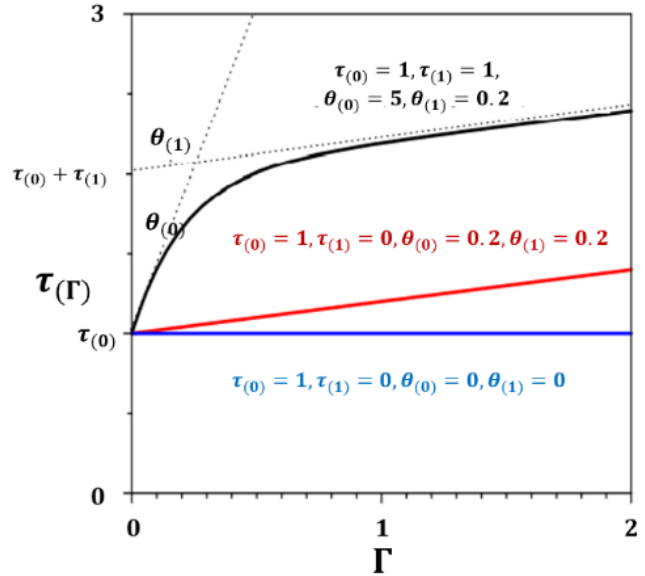
Figure 4. The geometric meaning of Voce hardening parameters.